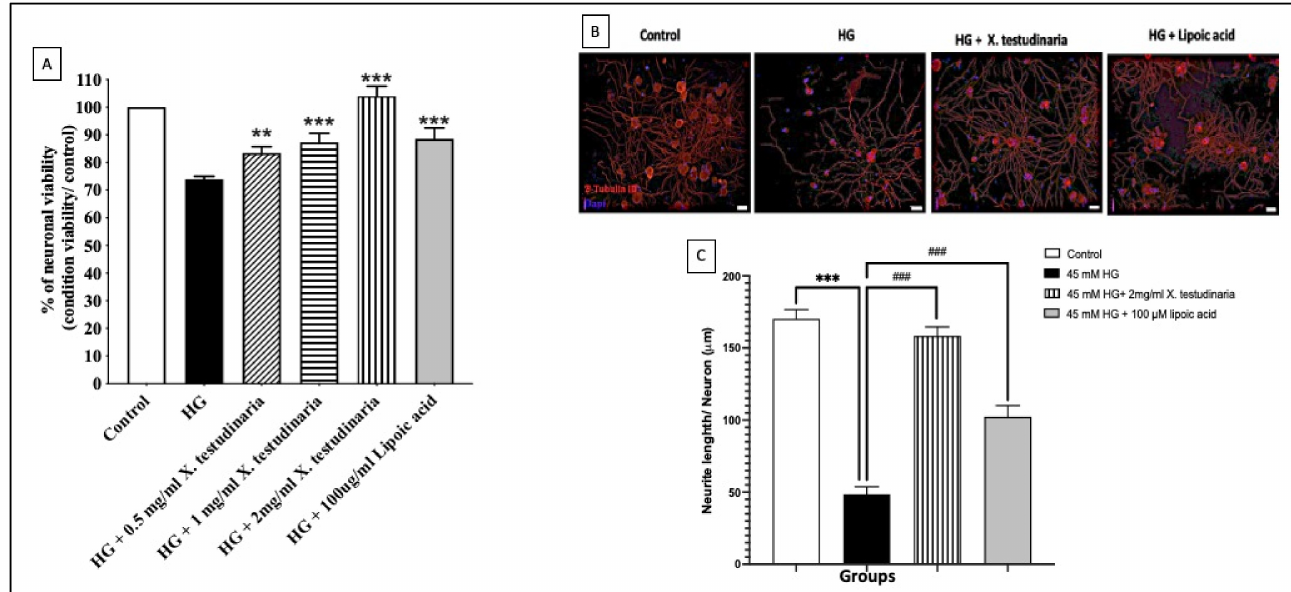
Figure 1. The effect of X. testudinaria extract on DRG neurons. ( A ) shows the effect of X. testudinaria extract on DRG viability. ( B ) shows the schematic tracings of the neurites from DRG culture in different groups. Neurites and nuclei were visualized with β -tubulin III and DAPI, respectively. ( C ) shows a quantitative analysis of total neurites length in DRG cultures. Data are presented as mean ± SEM of three independent experiments. Statistical analysis was carried out using a one-way ANOVA followed by Tukey post hoc test. **, ***: the data were statistically significant from the corresponding control group at p < 0.01 and p < 0.001, respectively. ###: the data were statistically significant from the corresponding high glucose (HG) group at p <